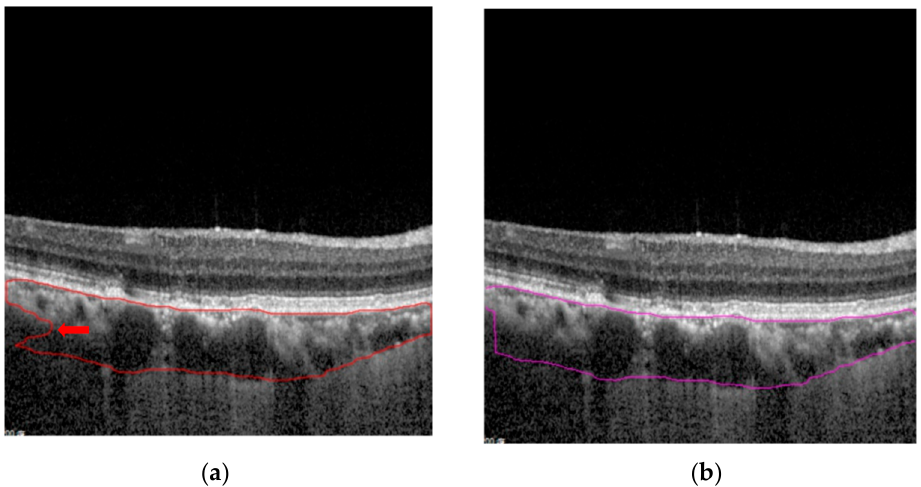
Figure 5. ( a ) Unreasonable dents on the boundaries before post-processing. ( b ) Refined boundaries by using the post-processing procedure. Table 1. The parameters used to execute the experiments for training and